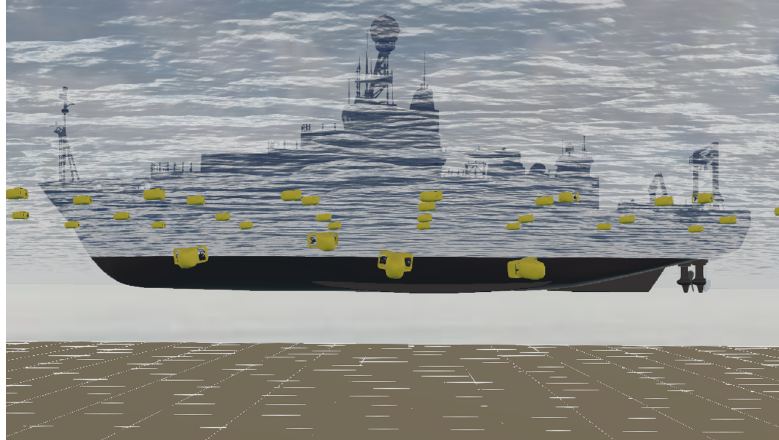
Figure 7. Underwater Webots simulation scene of 50 AUVs deployment, the USBL transceiver is hull-mounted on the deployment vessel.